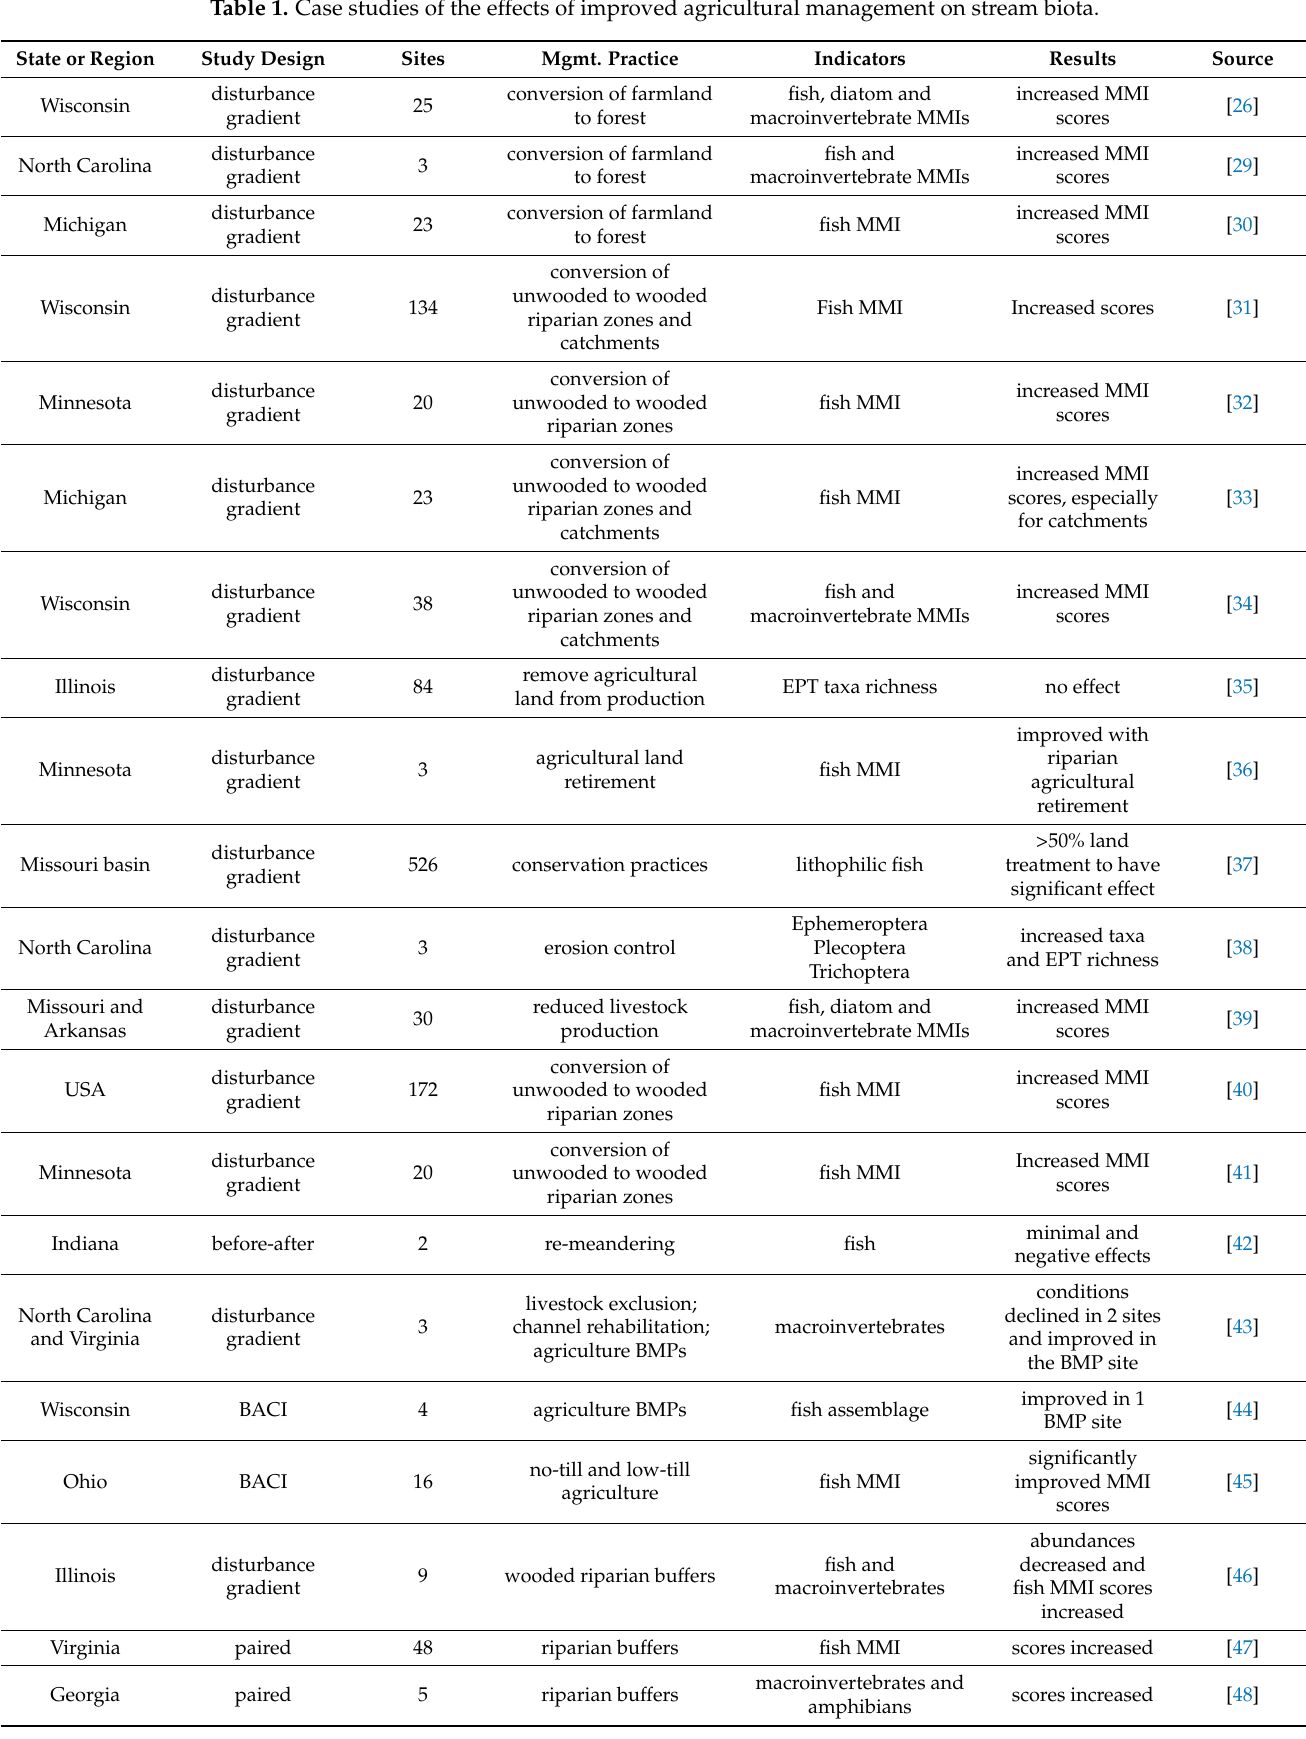
Table 1. Case studies of the effects of improved agricultural management on stream